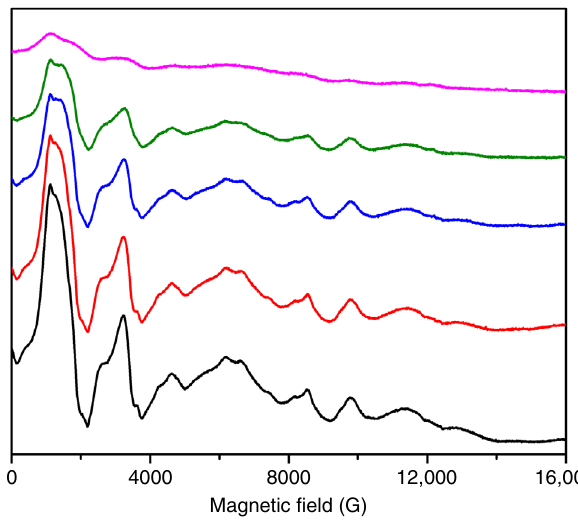
Fig. 5 EPR spectroscopic properties of powdered 3 in the solid state. Variable temperature Q-band (34 GHz) EPR spectra at 30 (magenta), 20 (green), 15 (blue), 10 (red), and 7 (black) K